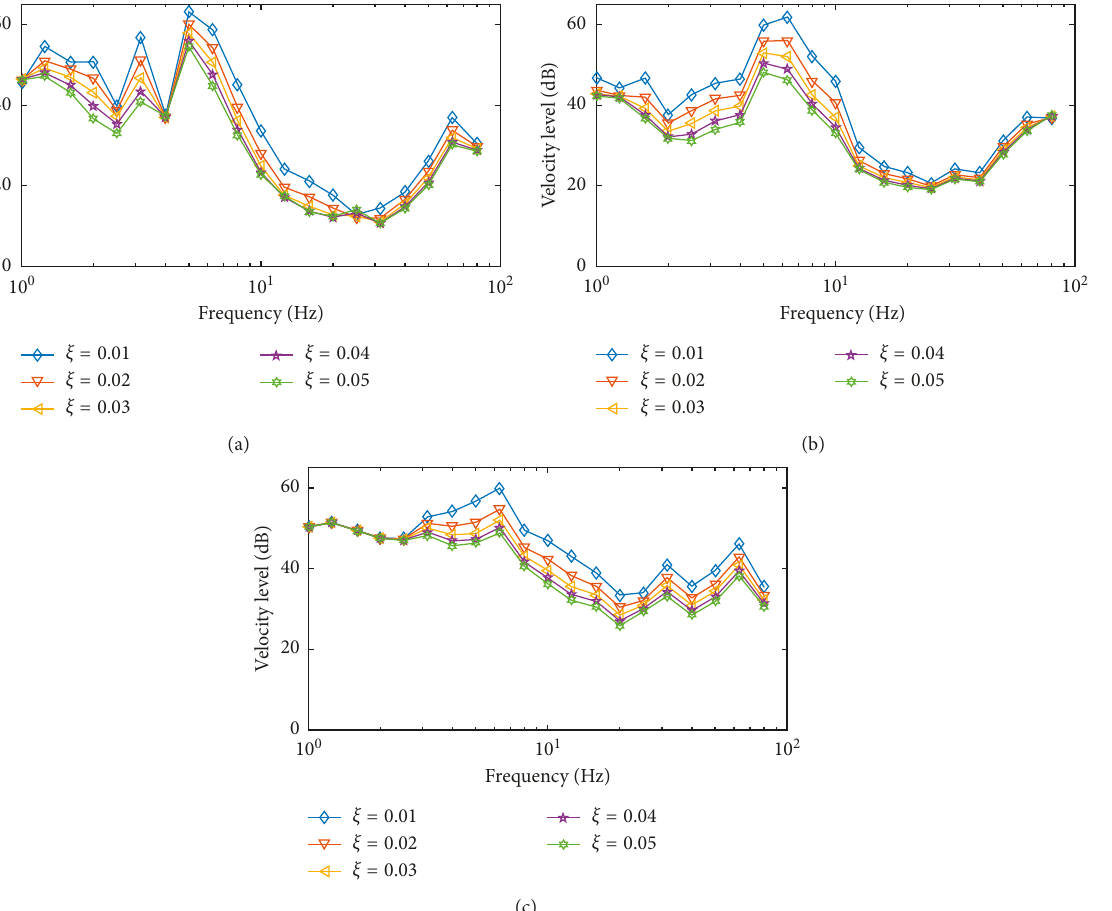
Figure 17: The average one-third octave spectra of the velocity level of typical story (6 th story) for different damping ratio. (a) X direction. (b) Y direction. (c) Z